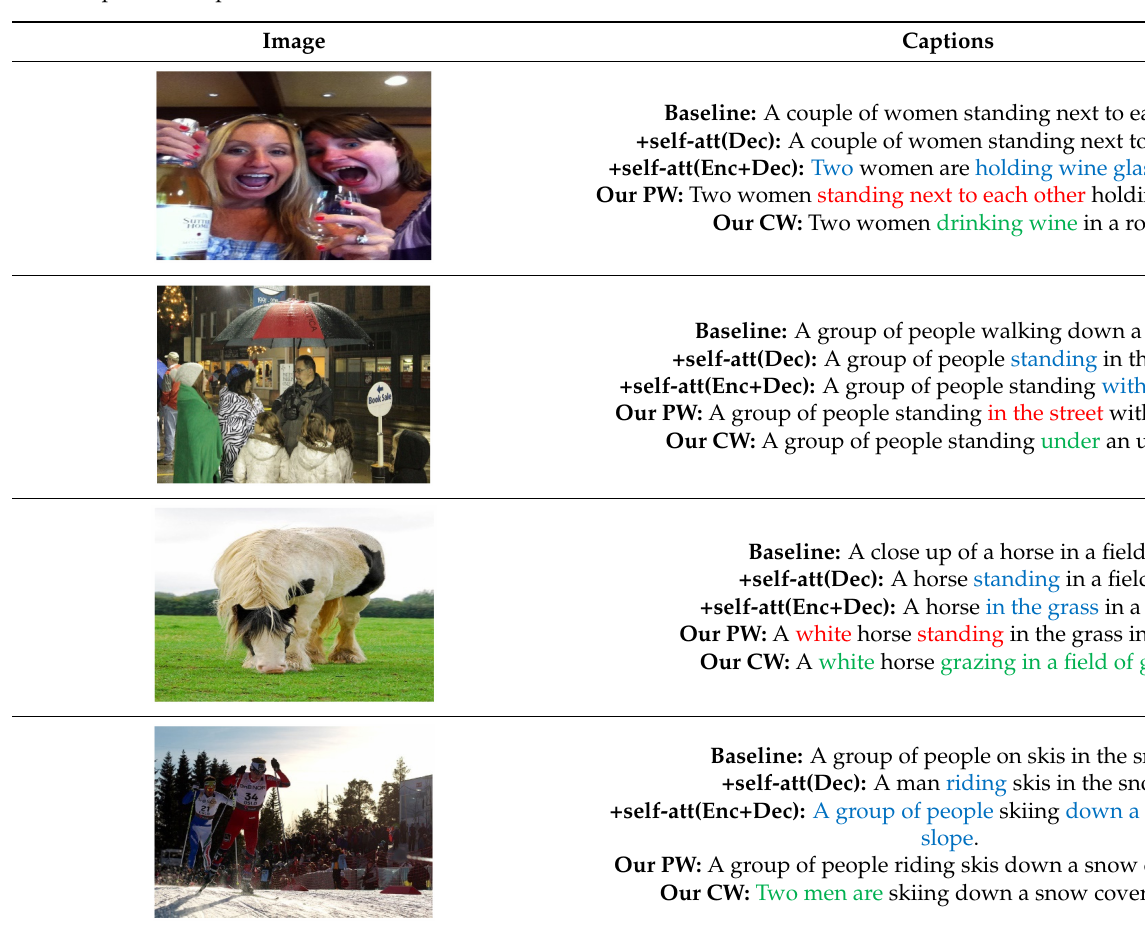
Table 6. Visualization of the generated captions of the ablated models, where the colored words are the improvements from the previous